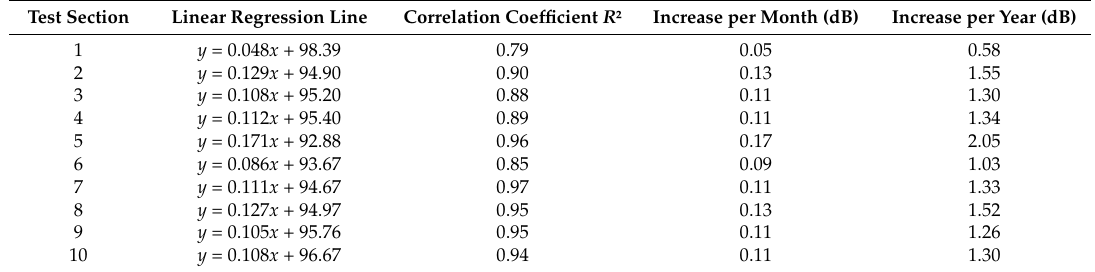
Table 5. Average noise increase per month and per year calculated from the CPX results (H1 tire).